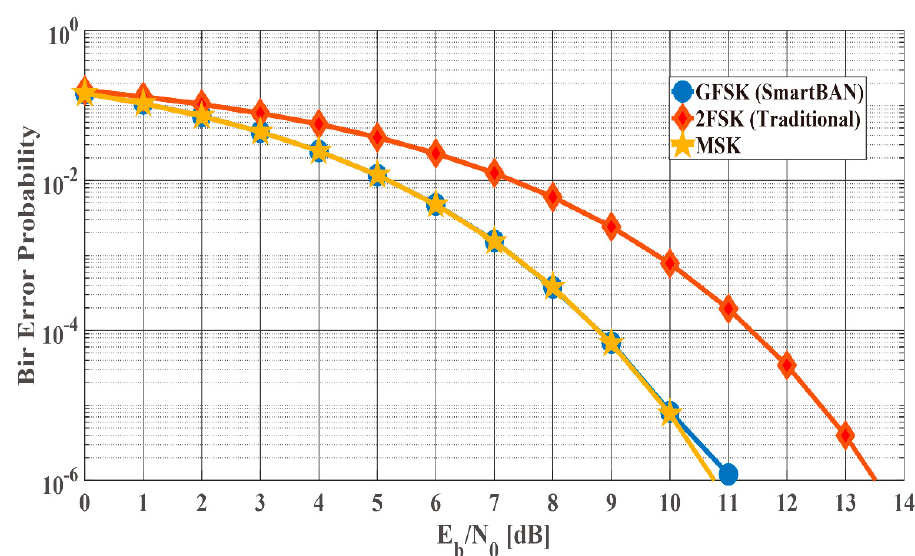
Figure 20. Bit error probability under the AWGN channel as a function of E s / N 0 . GFSK used in SmartBAN, minimum-shift keying (MSK) and 2FSK are compared.